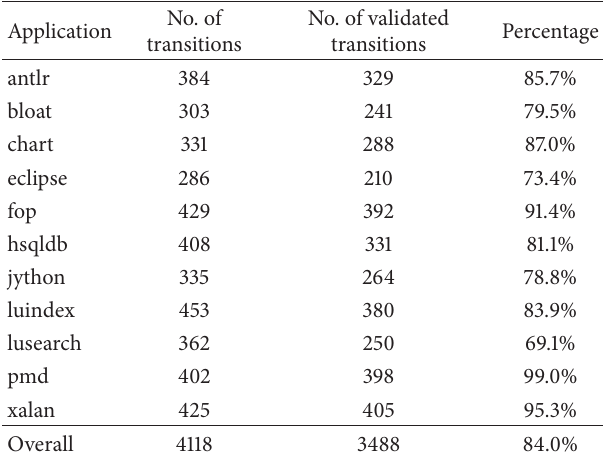
Table 5: Quality of mined typestates.